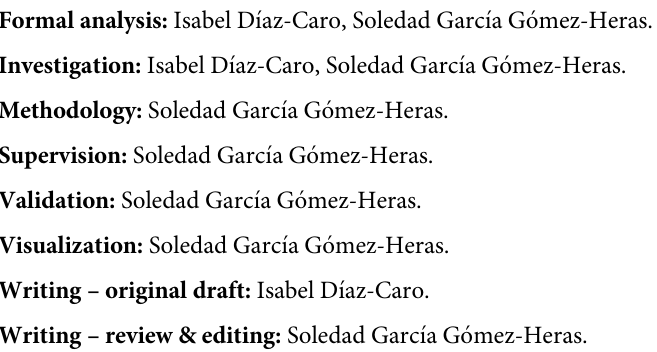
S1 Table. Statistics